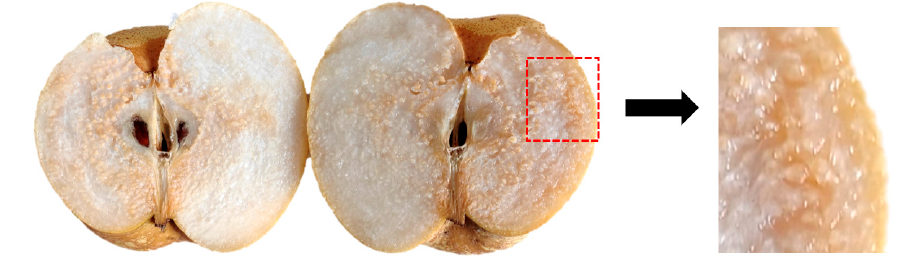
Figure 1. Diseased sample.